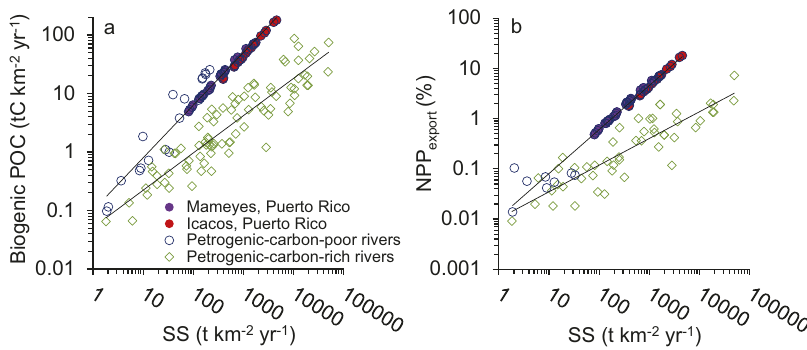
Fig. 2 River suspended load relationships for global rivers. The relationships are between a biogenic particulate organic carbon (POC) and b net primary productivity (NPP) export (%) relative to suspended sediment (SS) yield for global